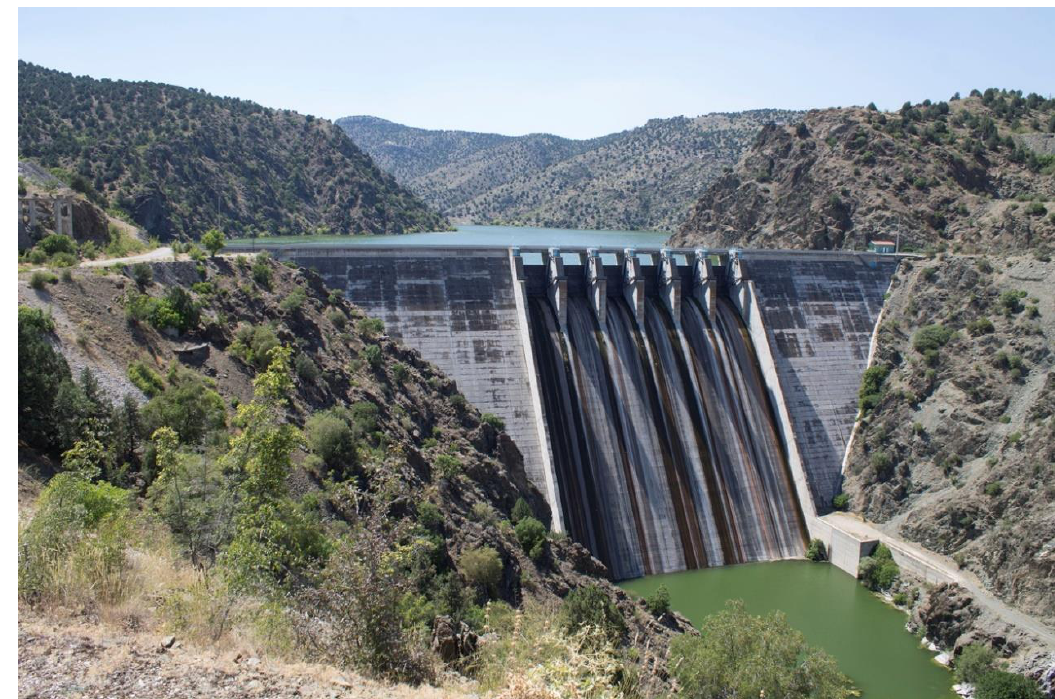
Figure 6. Sarıyar Dam—Turkey (photo taken by the author on 14 July 2016).